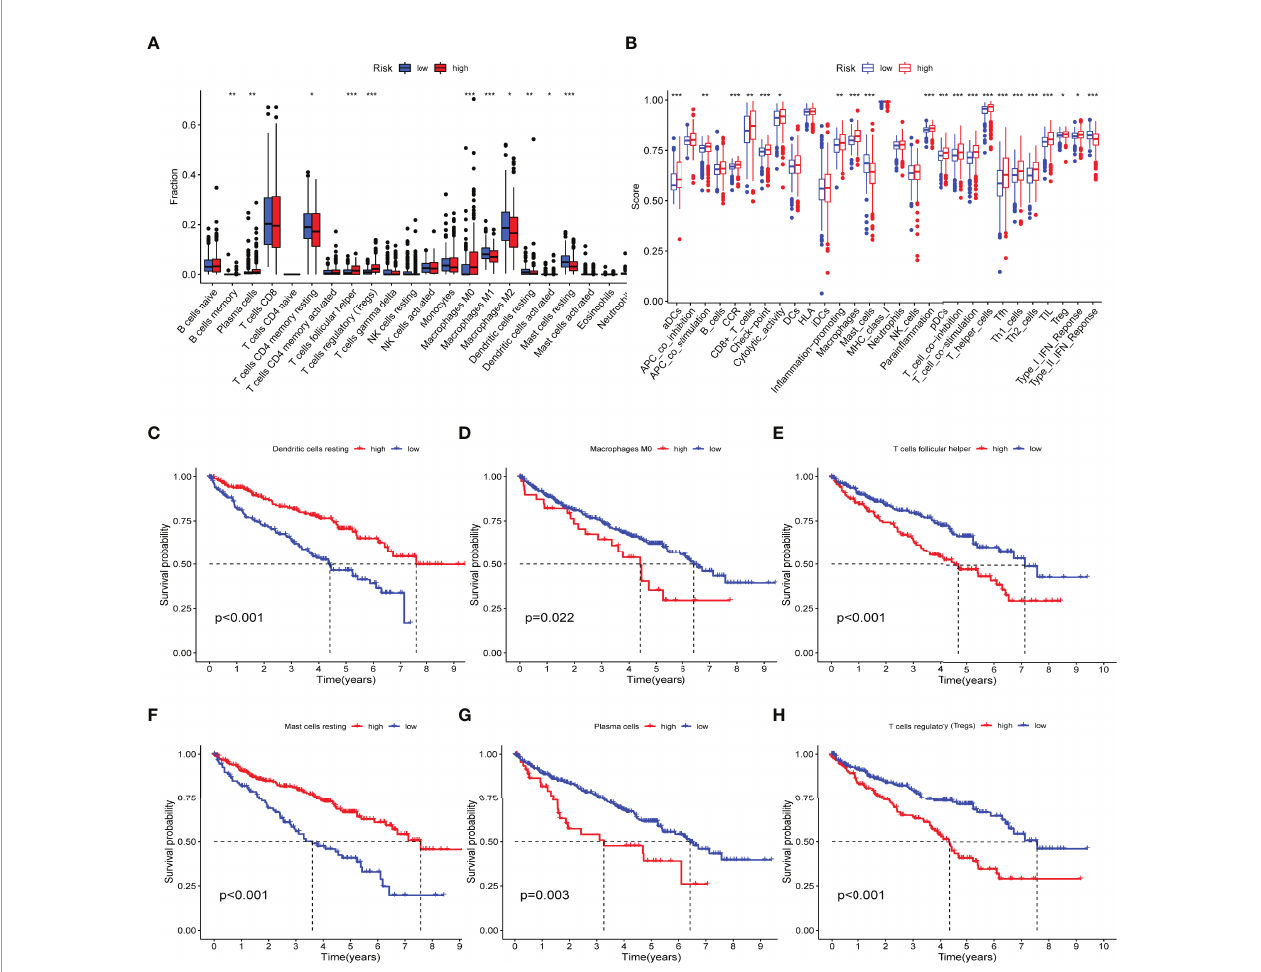
FIGURE 6 | Immunological pro fi ling of different subgroups of IRPDGs. (A) Differences in the distribution of tumor-in fi ltrating immune cells in TMEs of different IRPDGs subgroups. The difference between the two groups was statistically signi fi cant (ns: not signi fi cant, * P < 0.05, ** P < 0.01, *** P < 0.001). (B) Distribution of immunerelated functional indicators in different subgroups of IRPDGs. The difference between the two groups was statistically signi fi cant (ns: not signi fi cant, * P < 0.05, ** P < 0.01, *** P < 0.001. (C – H) Six tumor-in fi ltrating immune cells signi fi cantly associated with ccRCC